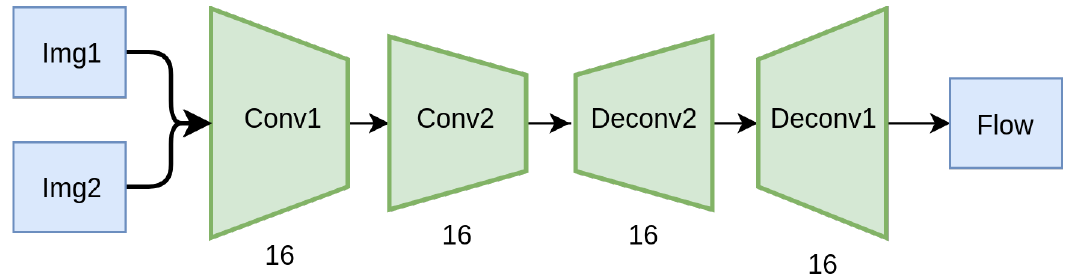
Figure 8. Overview of our baseline simple architecture. On the modified version CoordConv modules are appended to layers Conv1 and